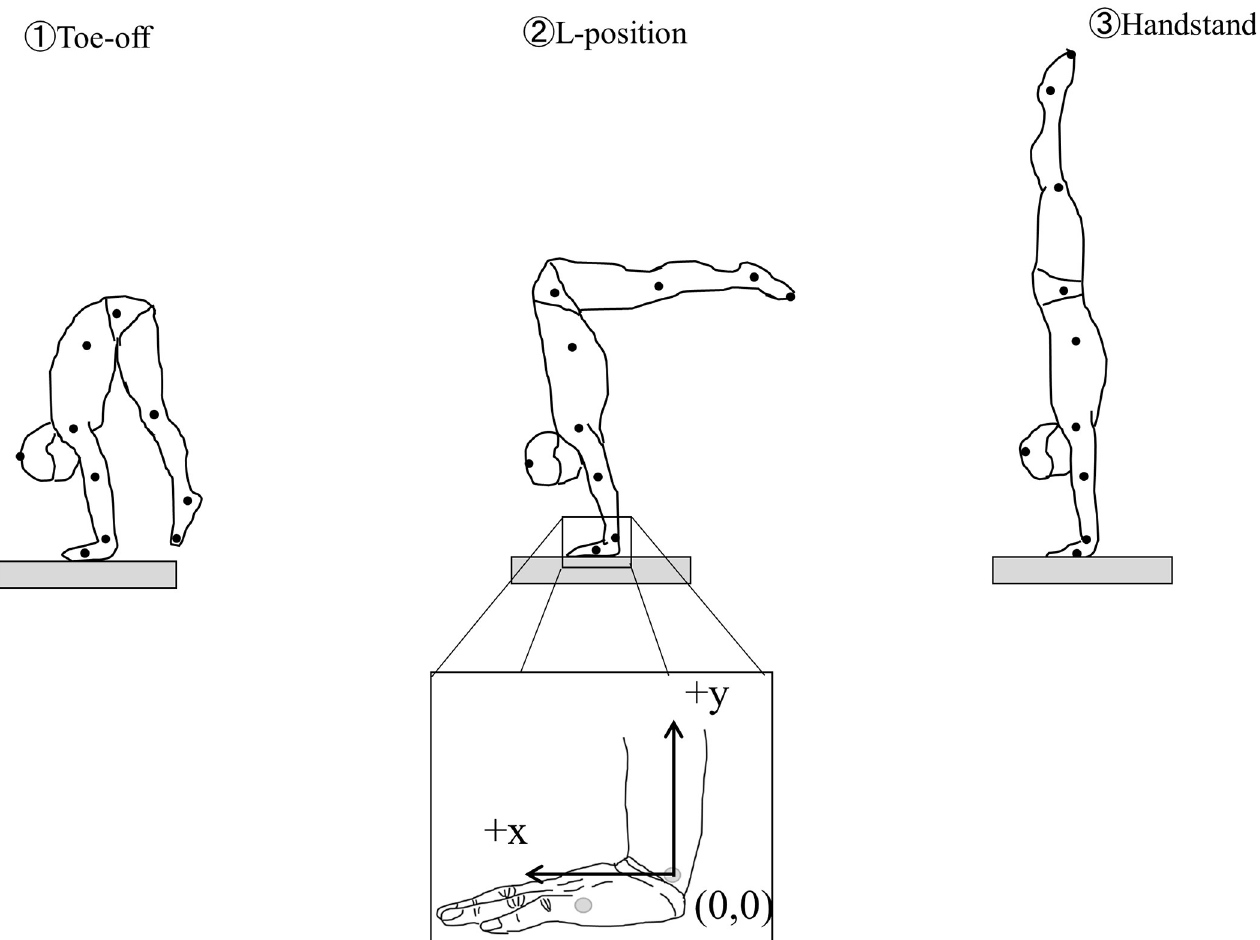
Fig 1. Typical straight arm press to handstand movement and three timings. ① Toe-off, ② Leg horizontal position, ③ Handstand. Origin of coordinate system was set as styloid process of